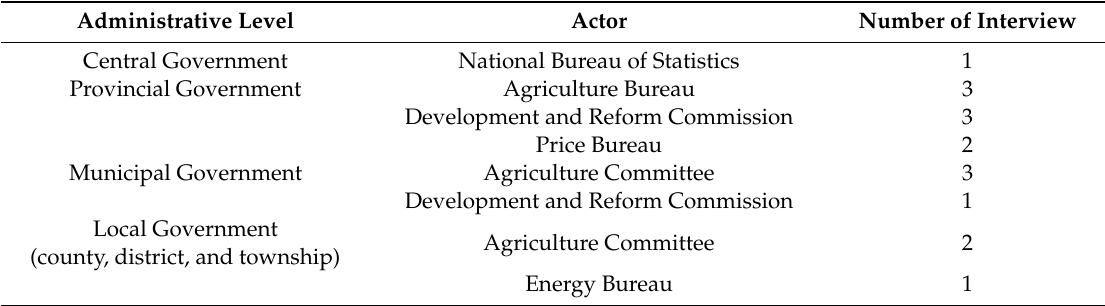
Figure 5. Hierarchy structure of government. Table 3. Interview information from government networks in the Yangtze River Delta.